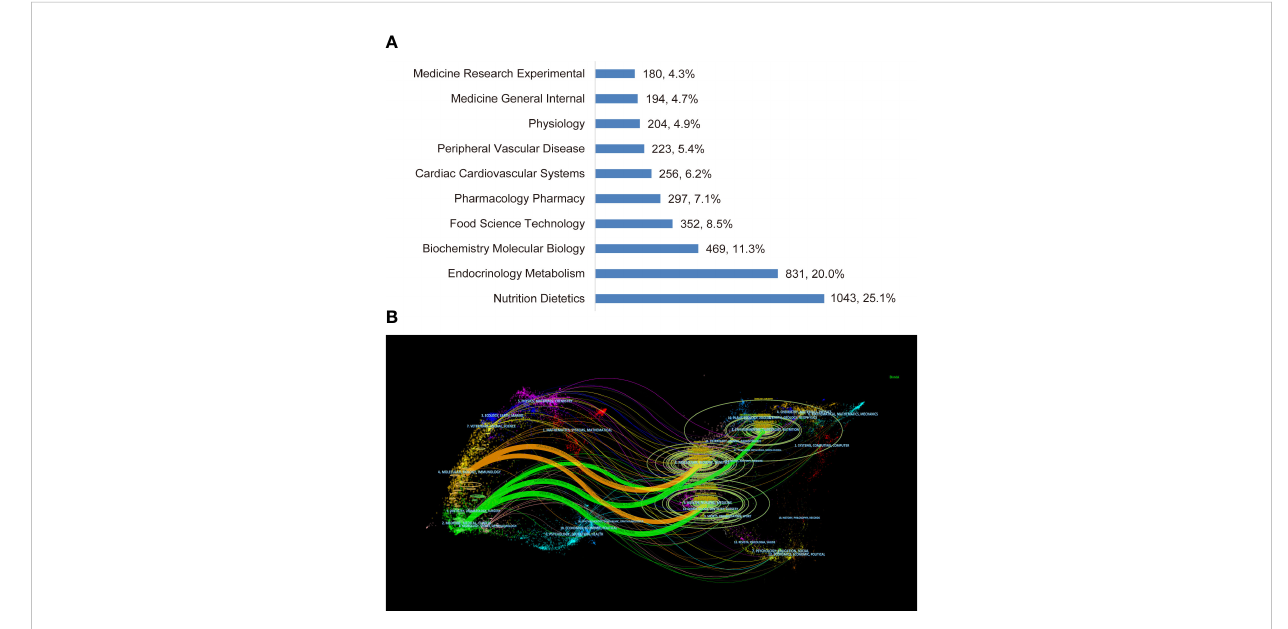
Figure 6A. The network of the co-cited journals is shown in Figure 6B. The American Journal of Clinical Nutrition , which was